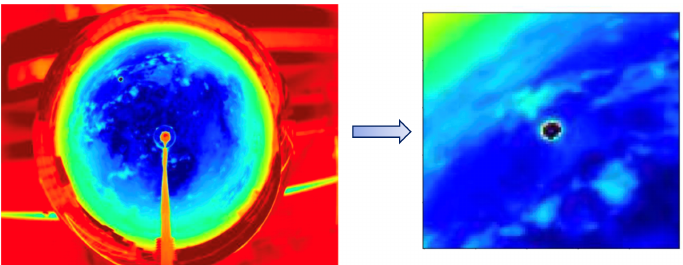
Figure 2. The infrared images are cropped based on the sun’s position in a way that the sun is located in the middle of each image in a square shape. The images are cropped since only the area around sun is